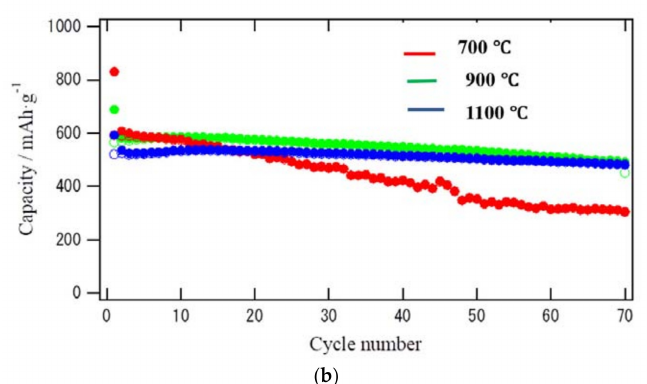
Figure 4. ( a ) Charge and discharge profiles and ( b ) cyclic performance of the Si/G/CP electrode with